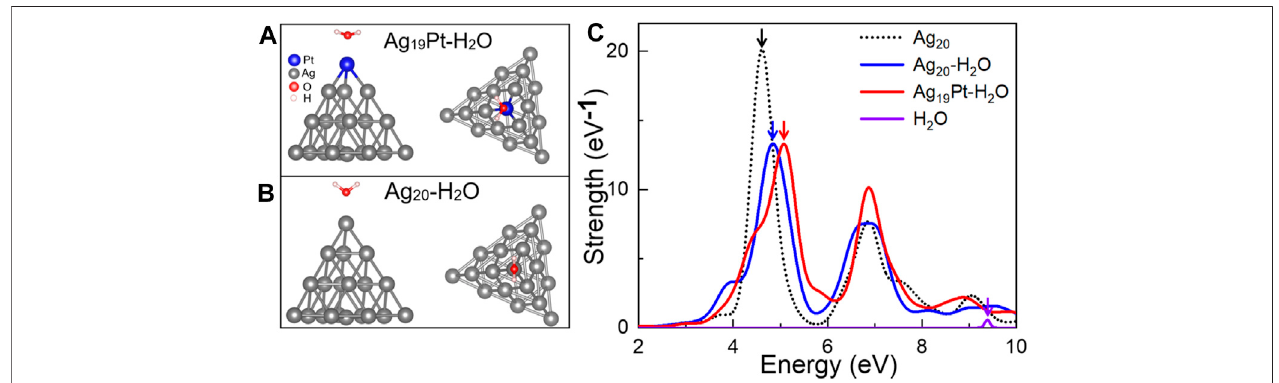
FIGURE1| Atomiccon fi gurationandabsorptionspectra.Thetopandsideviewsof (A) Ag 19 Pt – H 2 Oand (B) Ag 20 – H 2 Oaftergeometryoptimization. (C) Absorption spectra of Ag 20 , Ag 20 – H 2 O, Ag 19 Pt – H 2 O, and H 2 O, respectively. The colored arrows denote the position of the corresponding absorption peak.